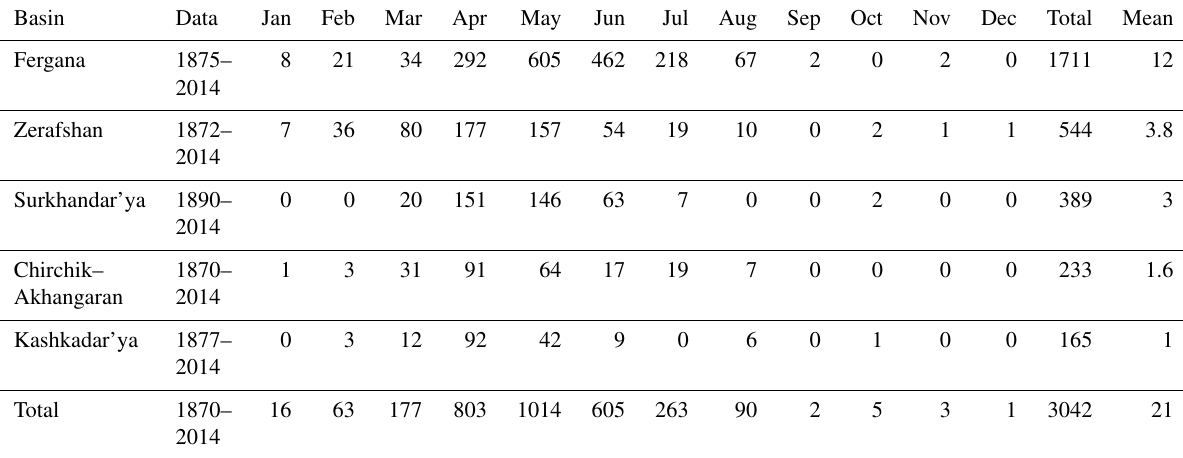
Table 1. Monthly distribution of mudflow events in five regions in Uzbekistan. Basin Data